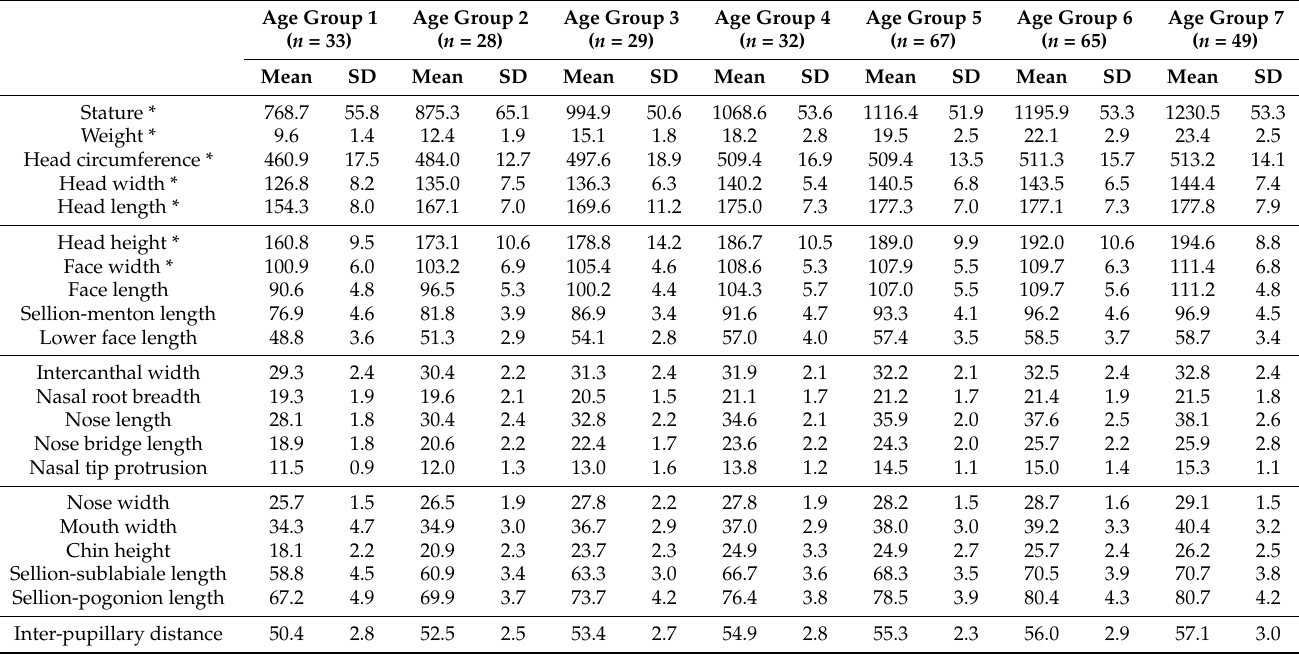
Figure 2. Data collection and processing of the 3D scan images, an overview of the steps (print screen: 3dMD Vultus software). Table 1. Mean and standard deviation for each dimension per age group where age group 1 consists of children aged 0.50 to 1.49 years, age group 2 consists of children aged 1.50 to 2.49, etc.